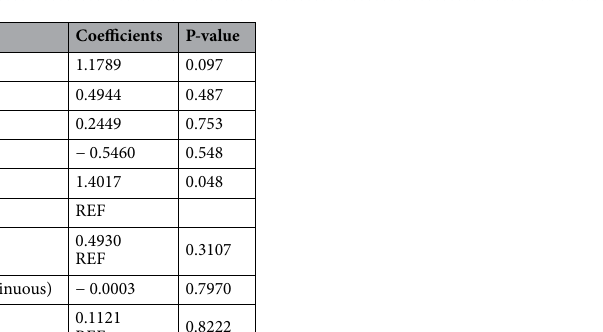
Figure 4. Duval and Tweedie’s Trim and Fill funnel plot.